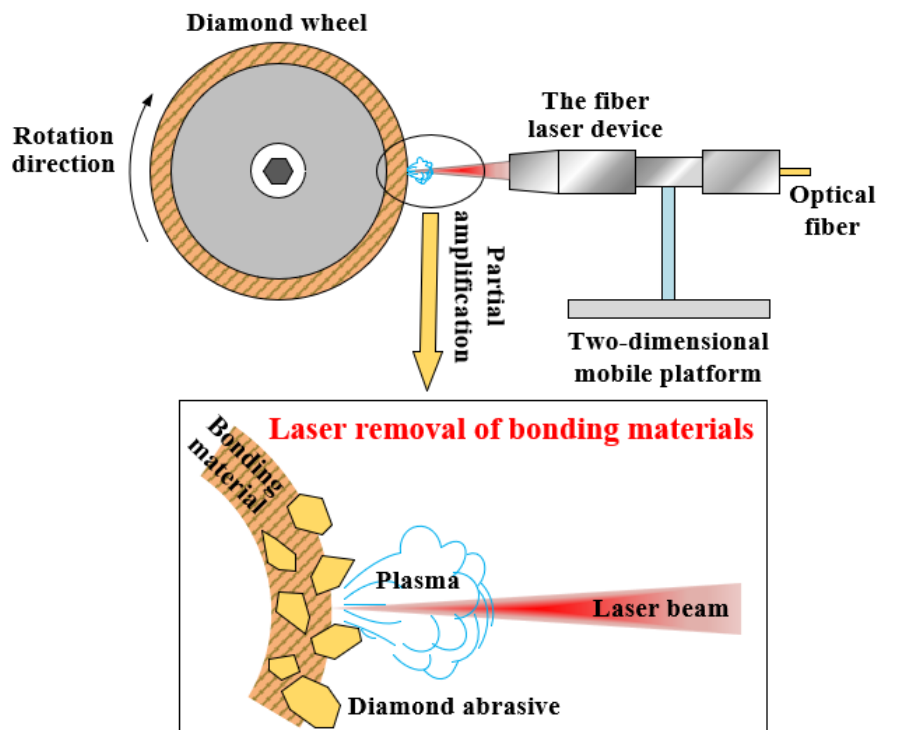
Figure 14. Schematic diagram of laser dressing diamond abrasive grinding wheel.